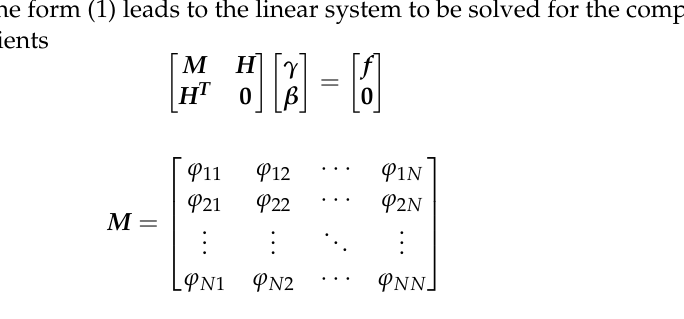
Figure 2. Overall flow chart of a mesh processing method, with snapping of the features of an orebody model.